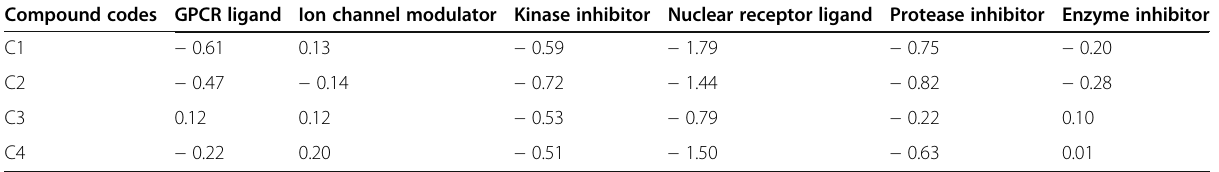
Table 3 Physical characterization of compounds